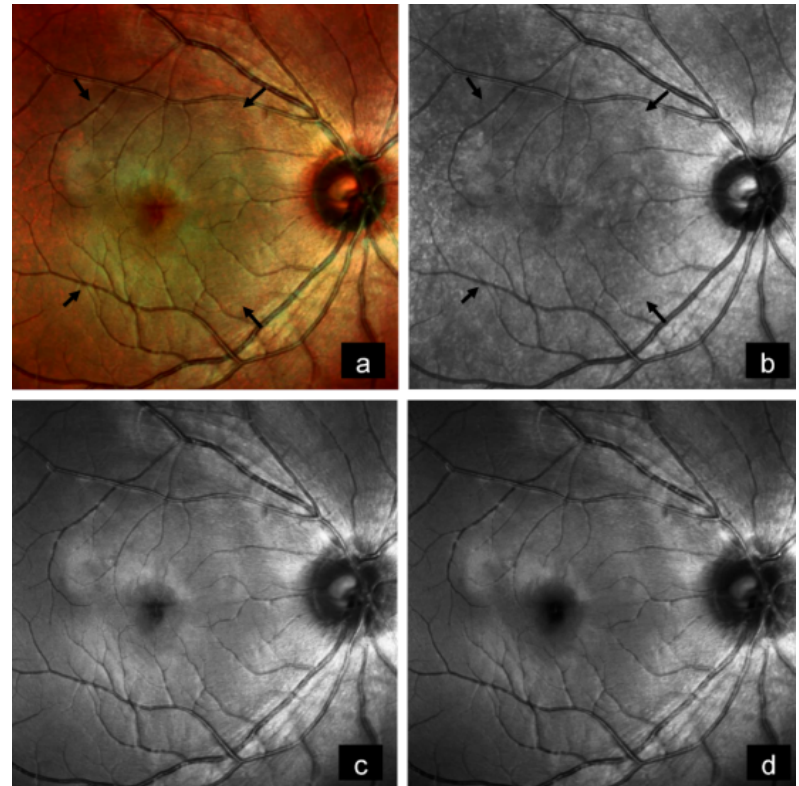
Figure 2: a) Multicolor image highlights the lesion showing greenish hue (arrows). b) Infrared reflectance shows hyporeflectance corresponding to lesion (arrows). c) Lesion cannot be picked up on green reflectance and d) on blue reflectance.